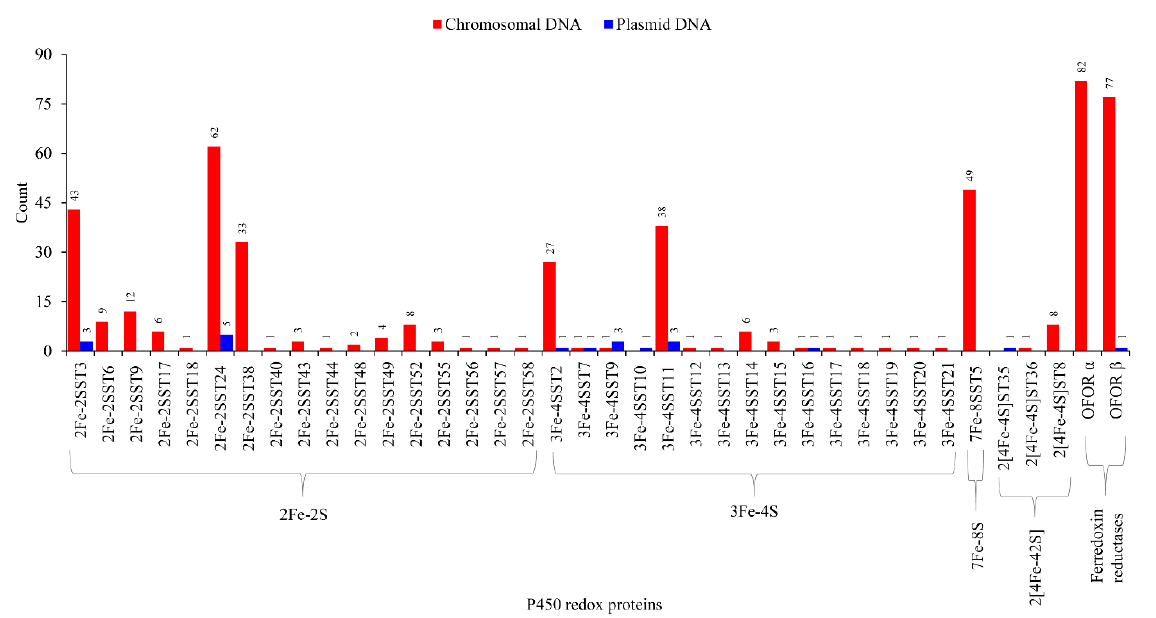
Figure 6. Comparative analysis of ferredoxins and ferredoxin reductase (OFOR) between chromo- somal and plasmid DNA. Ferredoxin types and subtypes and OFOR alpha and beta subunits were presented in the figure. Detailed information is provided in Tables S5 and S6.